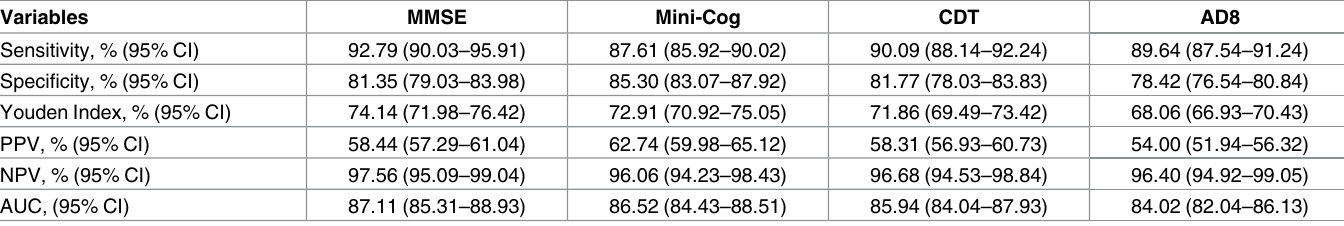
Table 2. Screening test characteristics of MMSE, Mini-Cog, CDT, and AD8.